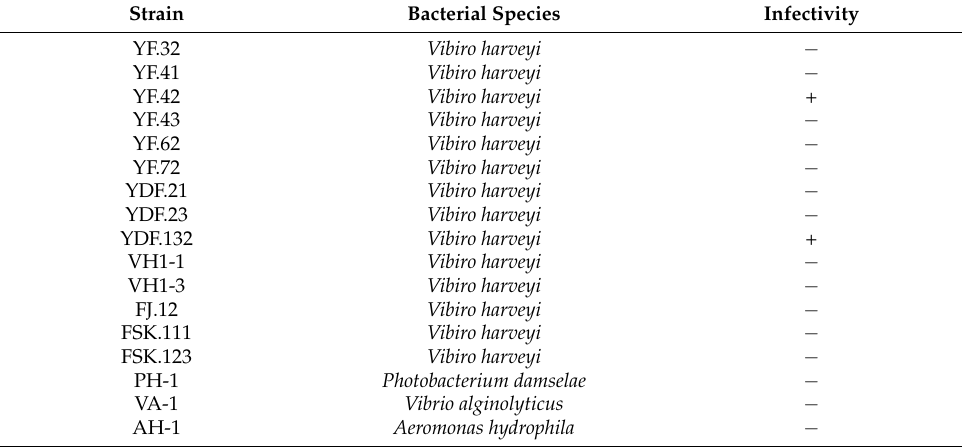
Table 1. The tested bacterial